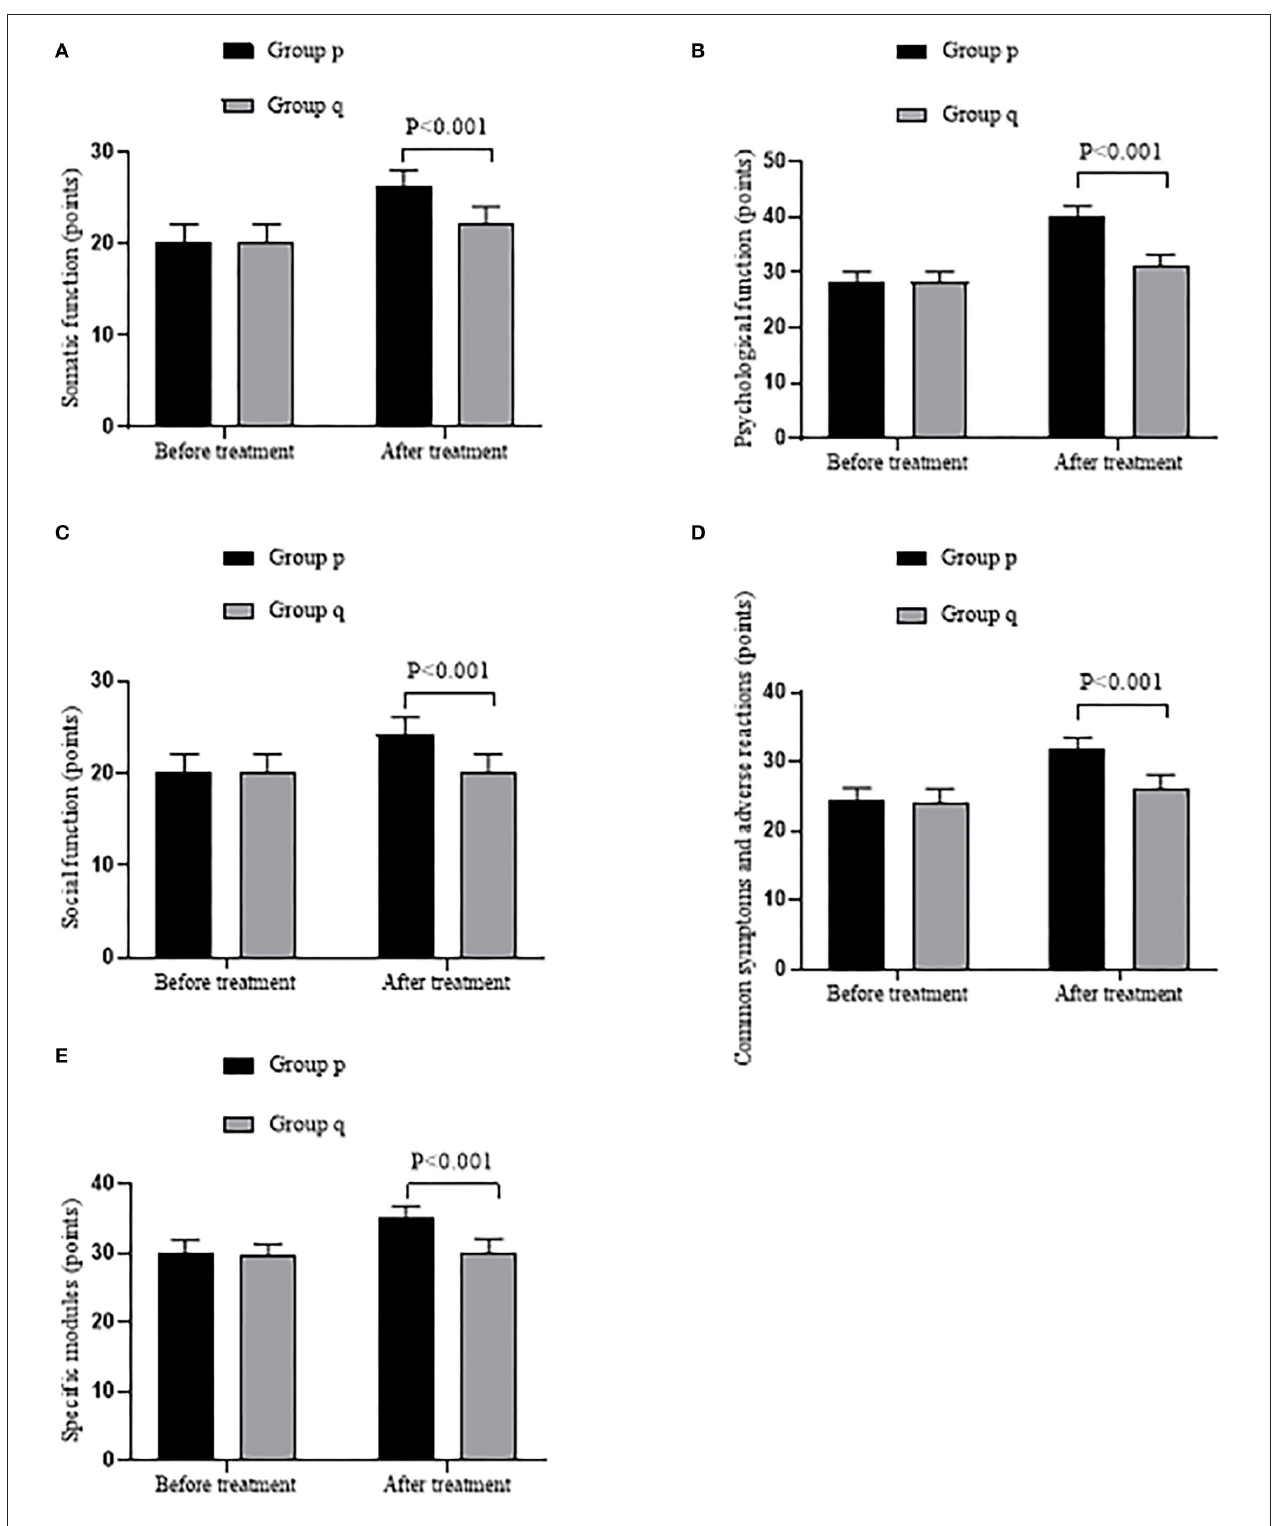
FIGURE 2 | Comparison of patient’s QOL ( ¯ x ± s, points). (A) showed the somatic function. (B) showed the psychological function. (C) showed the social function. (D) showed the common symptoms and adverse reactions. (E) showed the specific modules.